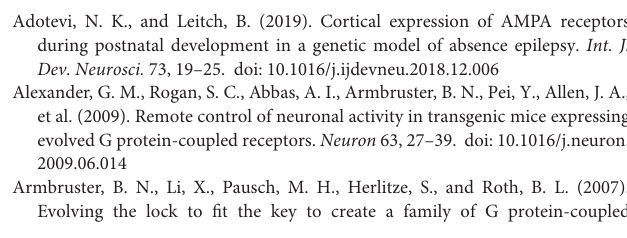
Supplementary Figure 1 | (A) Schematic showing breeding paradigm to generate PV-Cre × hM3Dq-flox offspring and WT (non-DREADD) control mice by crossing a female homozygous PV-Cre mouse with heterozygous hM3Dq-floxed mice. (B) Representative gel electrophoresis blot showing the homozygous (Homo) PV-Cre knockin (350 and 300 bp) and the hM3Dq-flox [heterozygous (Het) 300 and 204 bp and wild-type (WT) 300 bp] for three mice to verify PV-Cre knockin and hM4Di-flox. For the confirmation of PV-Cre knockin and hM3Dq-flox in the same mouse, genotyping was performed separately. Supplementary Figure 2 | Representative coronal slices of mouse brain showing histological localization of methylene blue dye injected via a cannula located in either (A) SScortex and (B) thalamus, verifying CNO site of diffusion within those regions. Coronal slice drawings were adapted from